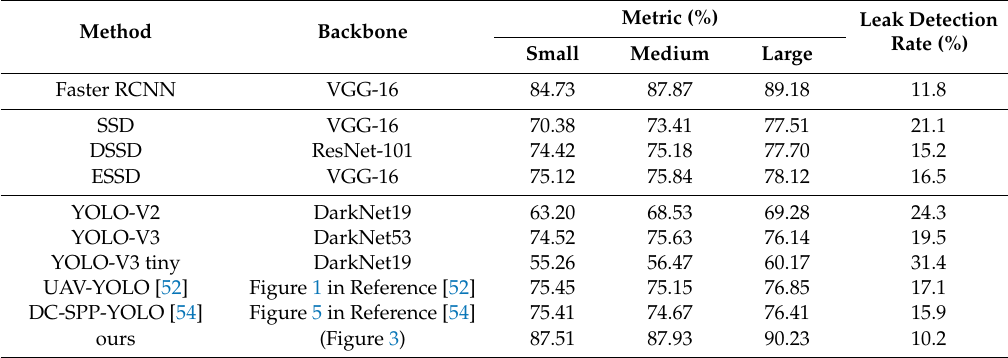
Table 8. Experimental comparison of accuracy measured by